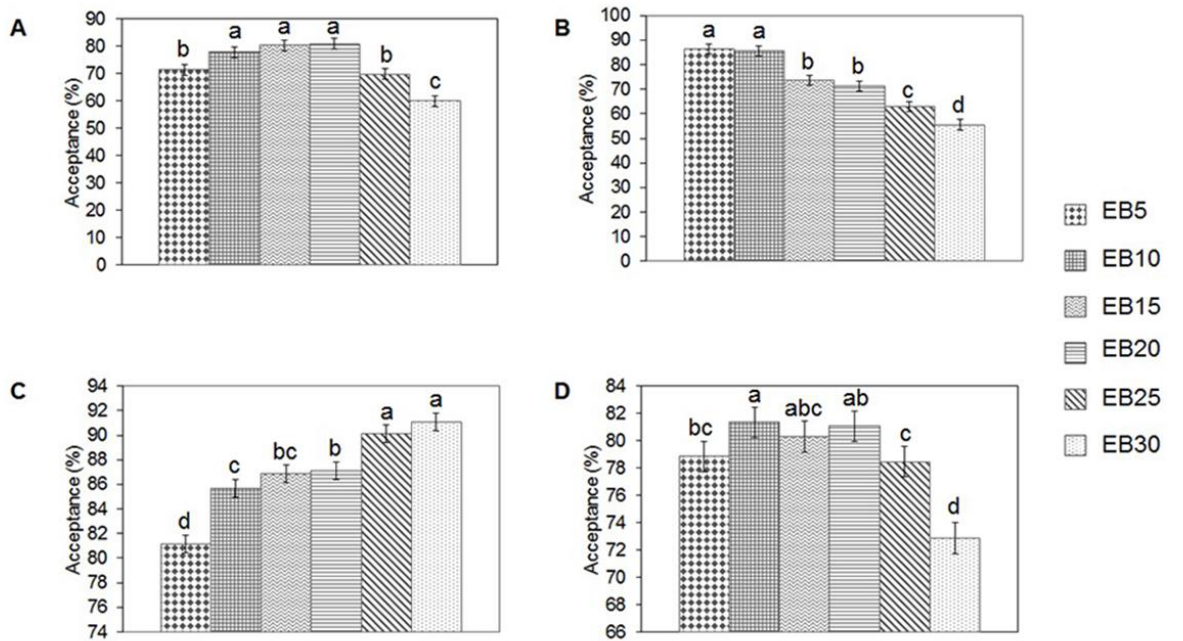
Figure 1. Sensory acceptance analysis of extruded sesame seeds byproduct flour beverages. ( A ) Fla- vor; ( B ) Color; ( C ) Smell; ( D ) Global Acceptability. EB5: Beverage with 5% extruded sesame seeds byproduct flour; EB10: Beverage with 10% extruded sesame seeds byproduct flour; EB15: Beverage with 15% extruded sesame seeds byproduct flour; EB20: Beverage with 20% extruded sesame seeds byproduct flour; BE25: Beverage with 25% extruded sesame seeds byproduct flour; BE30: Bever- age with 30% extruded sesame seeds byproduct flour. Different letters in the same graph indicate significant differences ( p < 0.05) among the means according to the Fisher’s test. pounds (9 phenolic acids, 12 flavonoids, and 3 melanoidins) could be identified (Figure 2; Table 1). The extrusion process modified the phenolic profile of the beverage more qualita- tively than quantitatively; seventeen of the 24 compounds were present in the unprocessed sesame seeds byproduct flour beverage − 10% (UB10) and 21 in the extruded sesame seeds byproduct flour beverage − 10% (EB10). The compounds caffeic acid, luteolin-7- O -glucoside, and isorhamnetin were identified only in UB10; while vanillic acid, acteoside, luteolin, quercetin, and melanoidins only in EB10. Except for isorhamnetin and melanoidins, all the compounds had been previously identified in sesame